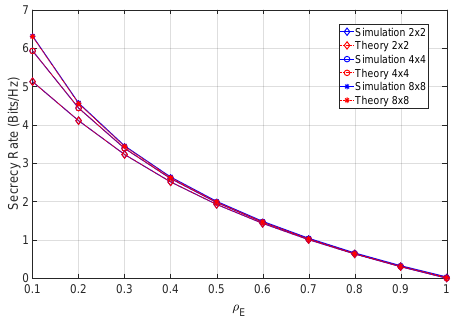
Figure 5. Secrecy rate of the system for an SNR of 12 dB and different MIMO